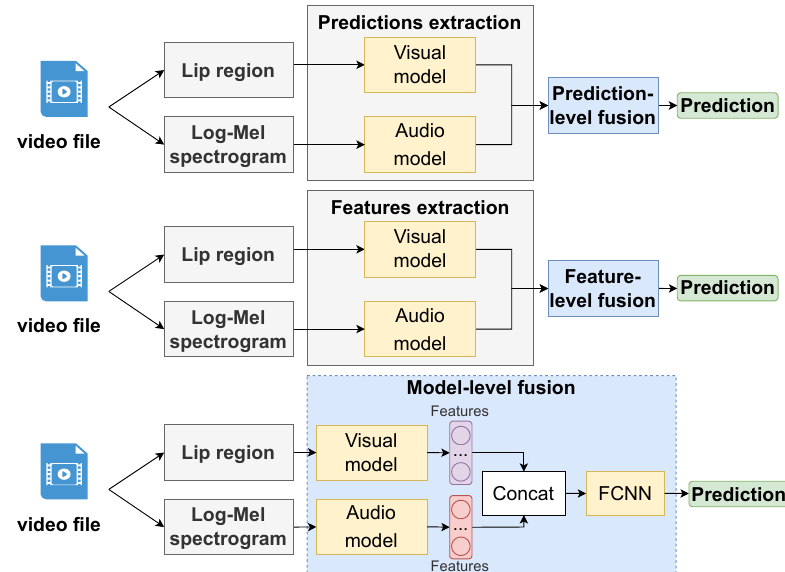
Figure 5. Modalities fusion